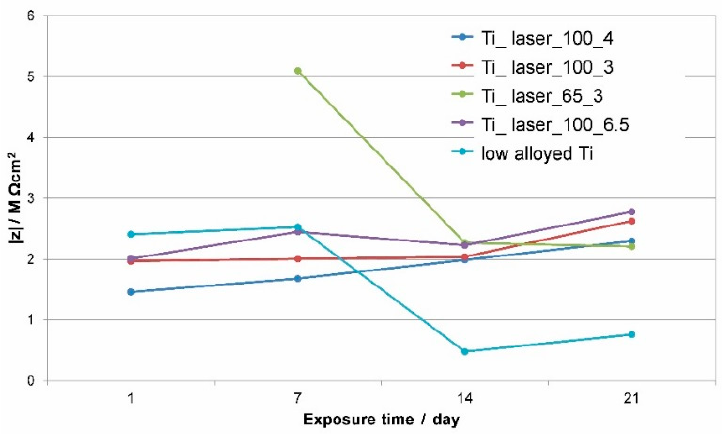
| Z | of Ti surfaces in 0.1 M NaCl during 3-week Figure 5. Total impedance |Z| of Ti surfaces in 0.1 M NaCl during 3-week exposure. Figure 5. Total impedance